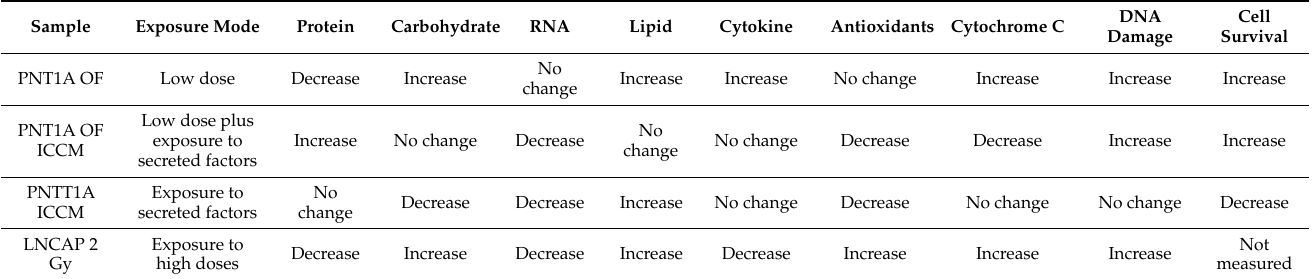
Table 6. Summary of spectral changes observed by exposure mode.